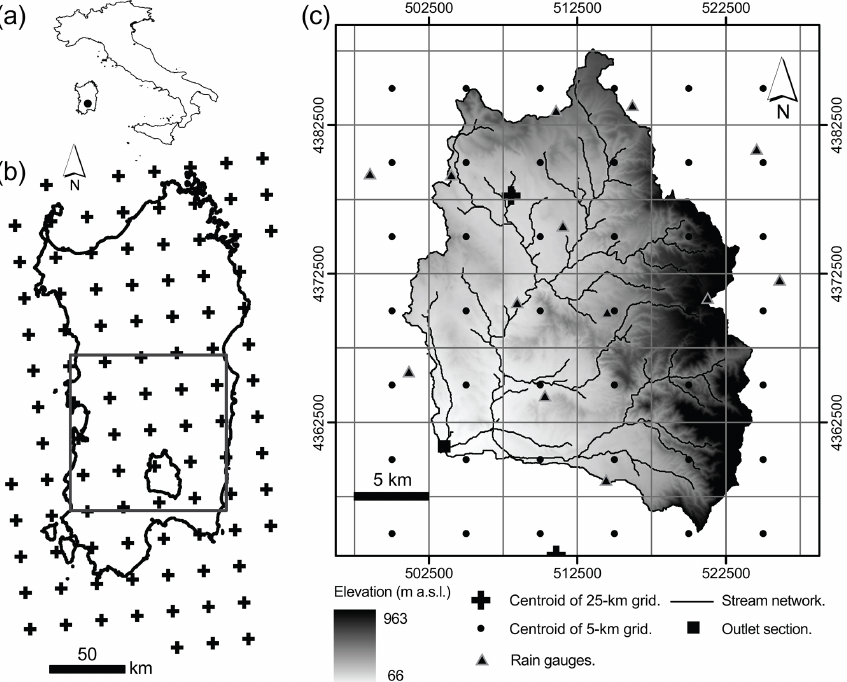
Figure 1. Location of the RMB within (a) Italy and (b) the island of Sardinia. (c) DEM of the RMB in UTM (universal transverse Mercator) coordinates. In (b) and (c) , crosses are centroids of the 25km grid of the RCMs, and the black square is the 104km × 104km coarse-scale domain for the precipitation downscaling scheme. In (c) , the circles are the centroids of the 5km grid of the disaggregated precipitation products, and the triangles are the rain gages used to perform the local-scale bias